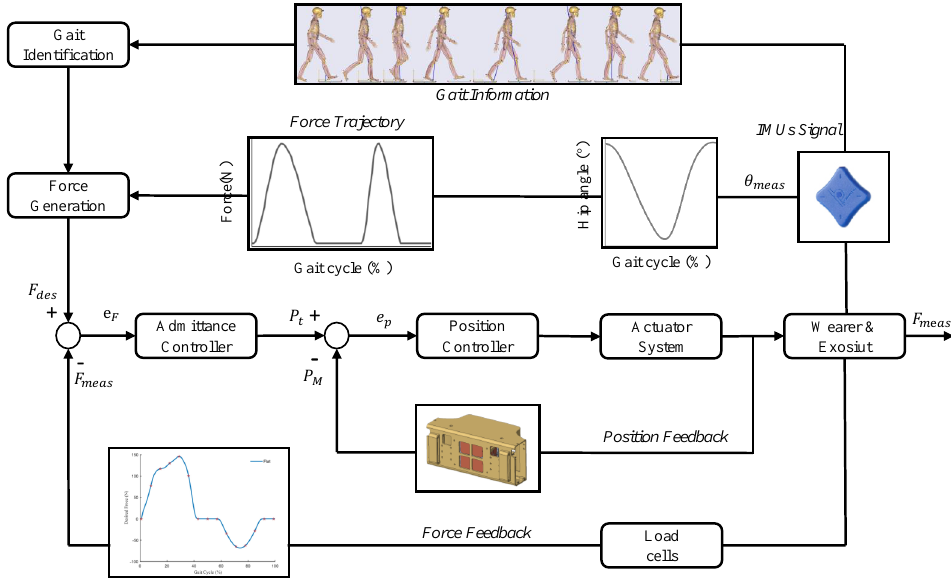
Figure 6. The lightweight soft exosuit control system. F des : desired force, F meas : measured force, e F : force error, P t : target position of the motor, P M : measured position, e p : position error, θ meas : measured